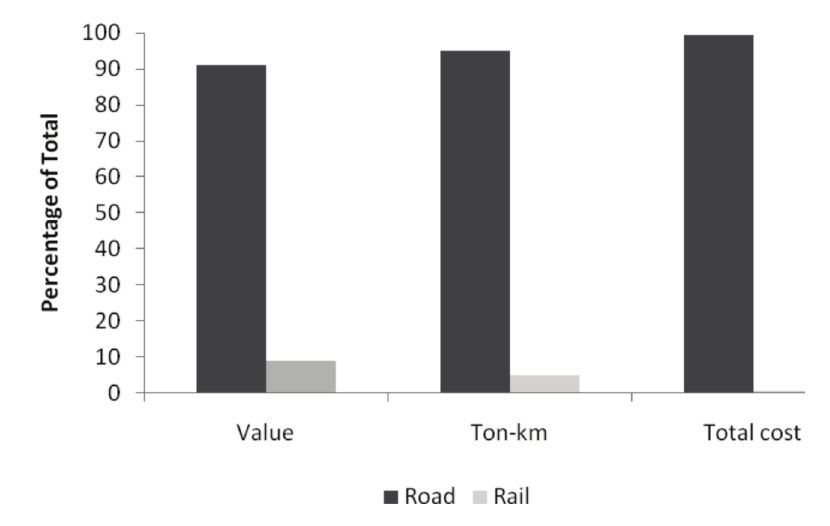
Figure 2: Rail’s negligible role in branch line-related traffic (data source: FDM, 2009, and CSCM Cost Model,